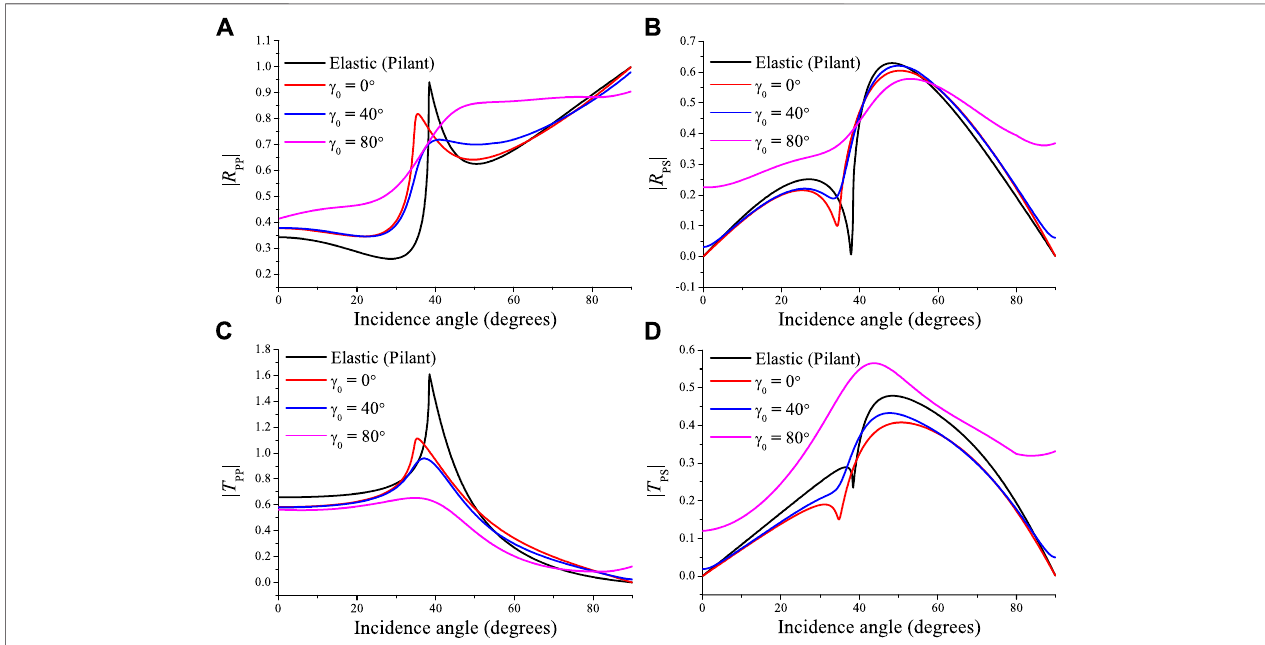
FIGURE 4 | Absolute values of the re fl ected P (A) , re fl ected S (B) , transmitted P (C) and transmitted S (D) waves as a function of the P-wave incidence angle, corresponding to the elastic (black lines) and thermoelastic (color lines) cases at 100 MHz for different values of γ 0 .